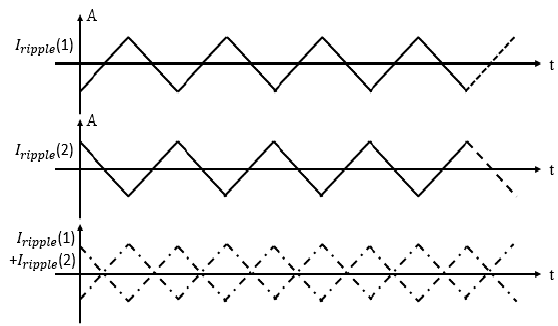
Figure 5. Geometrical nullification.